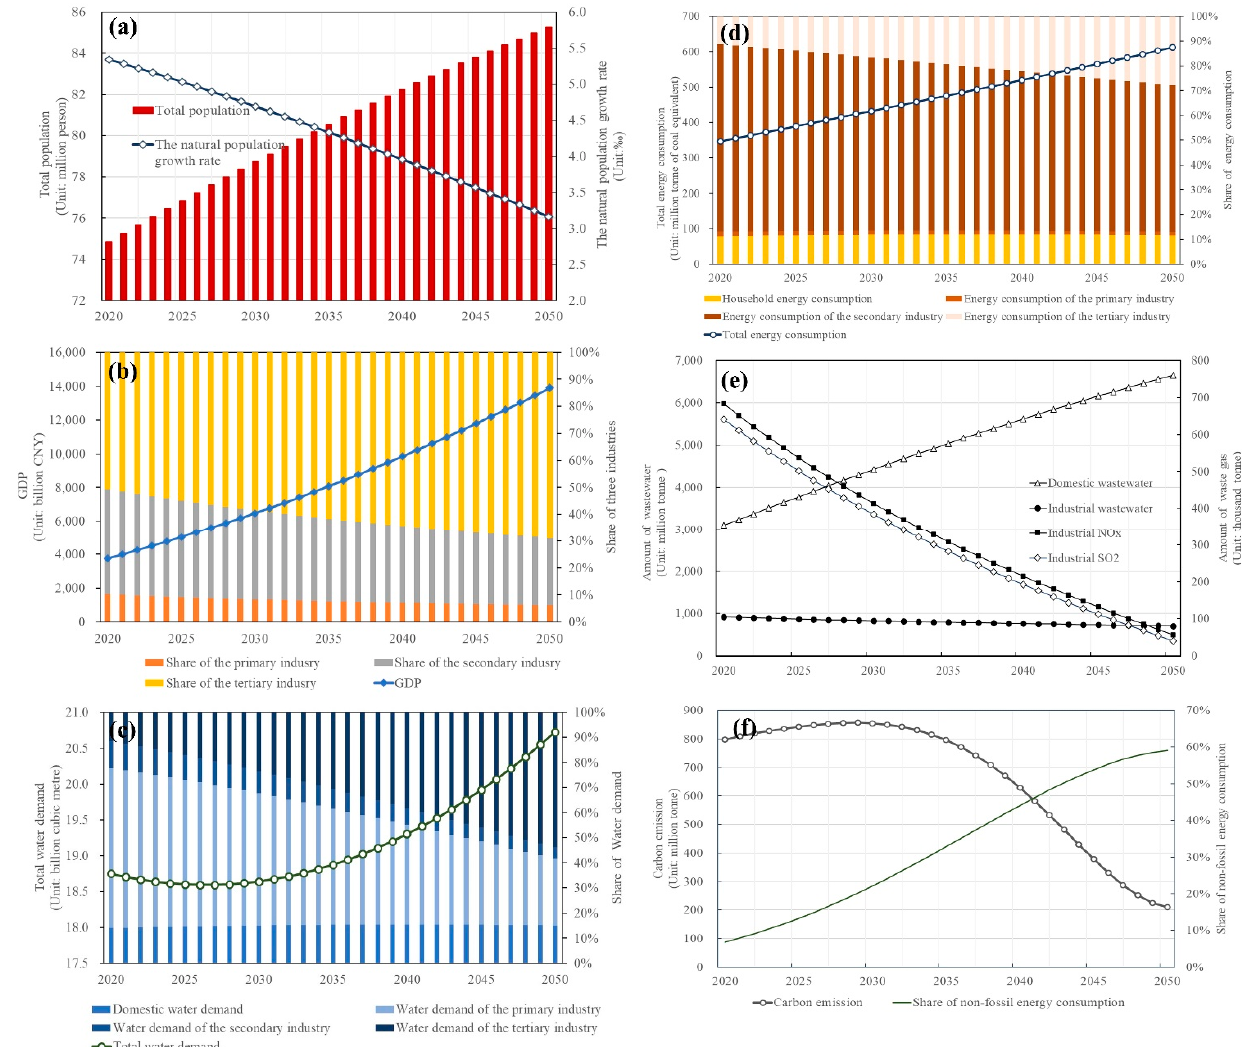
Figure 3. Trends of socioeconomic variables of natural development scenario in the Hebei urban metabolic system 2020–2050 (( a ). Total population and its growth rate; ( b ). GDP and share of three industries; ( c ). Total water demand and share of different water demand; ( d ). Total energy consumption and share of different energy consumption demand; ( e ). Amount of wastewater and waste gas; ( f ). Carbon emission and share of non ‐ fossil energy consumption). Table 2. Trends of social and economic variables in the Hebei urban metabolic system in 2020, 2035, and 2050.